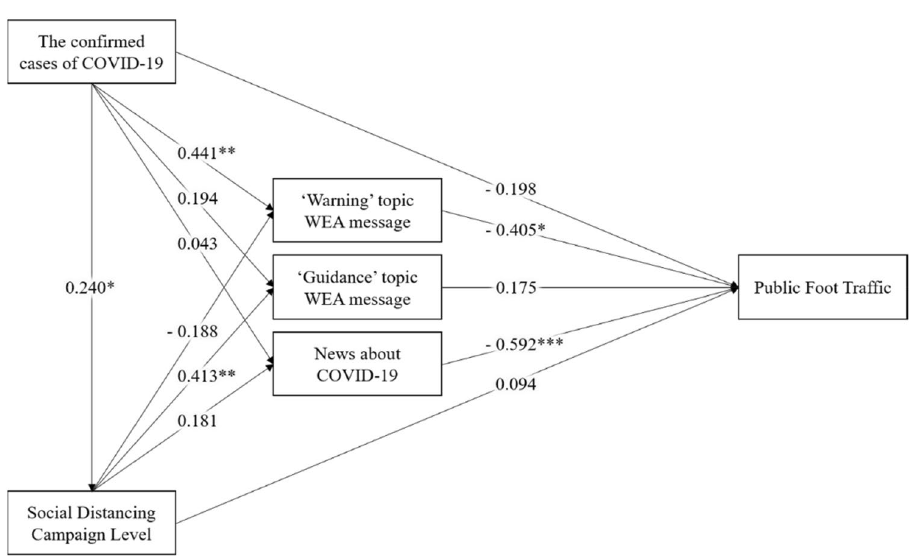
Figure 4. Partial least squares path model for Ulsan metropolitan city (*p < 0.05, **p < 0.01, ***p <